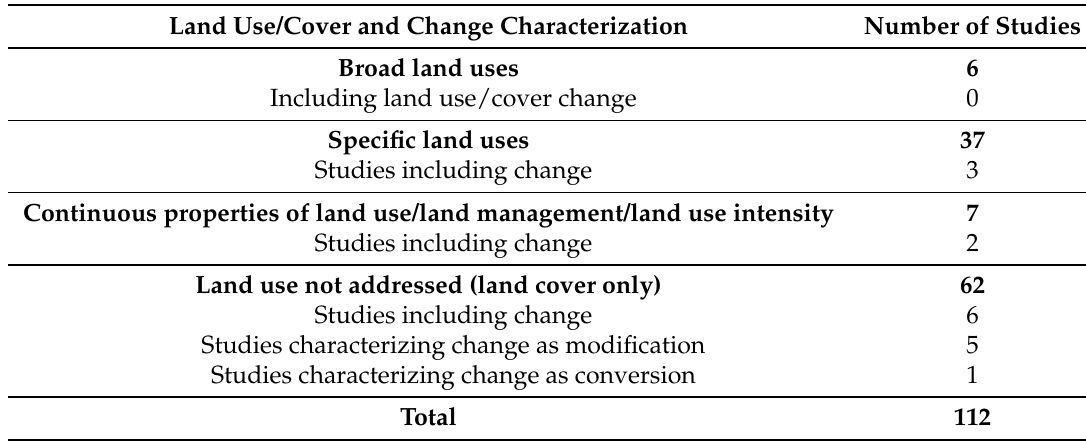
Table 2. Summary of land use or land cover characterized in the